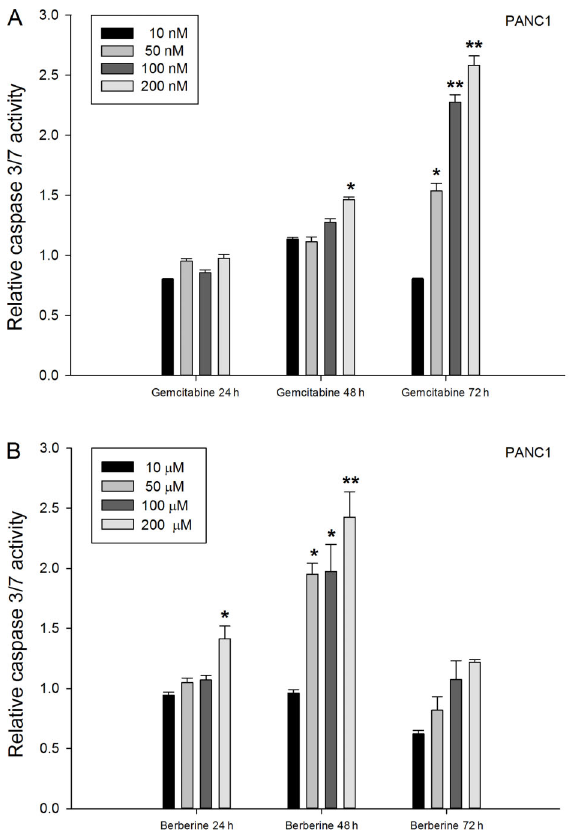
Figure 6. A , Caspase 3/7 activities after treatment of PANC1 cells with gemcitabine ( A ) and with berberine ( B ) for 24, 48, and 72 h. Data are reported as means±SD activity (n > 3) relative to control. *P , 0.05, **P , 0.01 versus control (Student’s